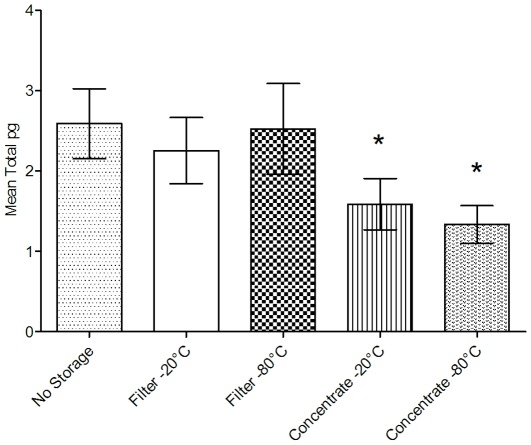
Effect of storage condition on mean cytokine levels.Mean cytokine levels (pg) across five different storage conditions (95% CI, N = 156, 6 filters assayed in duplicate for each of 13 human cytokines). * indicates statistically significant difference from No Storage control condition (Kruskal-Wallis ANOVA, P<0.05).